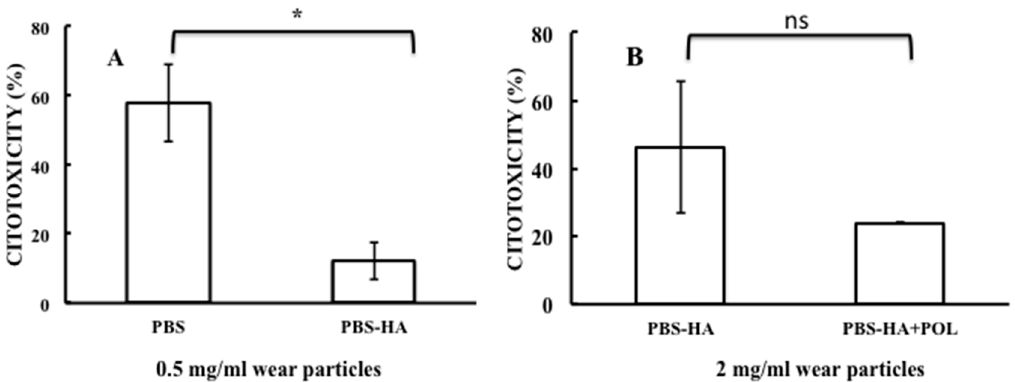
Figure 6. Macrophage cytotoxicity, measured as LDH activity, of cell cultures exposed for 72 h to HCCoCr wear particles . Panel A: Exposure of macrophages culture to 0.5 mg/mL wear particles. Particles were obtained in PBS and in PBS containing 3 g/L HA (PBS-HA). A p value of ≤ 0.05 was considered significant (*); Panel B: Exposure of macrophages culture to 2 mg/mL wear particles obtained in PBS containing 3 g/L HA with and without polarization application, PBS-HA+POL and PBS-HA, respectively. Experimental data were done as independent triplicate. Differences between data analyzed here were not significantly different (labeled as ns).